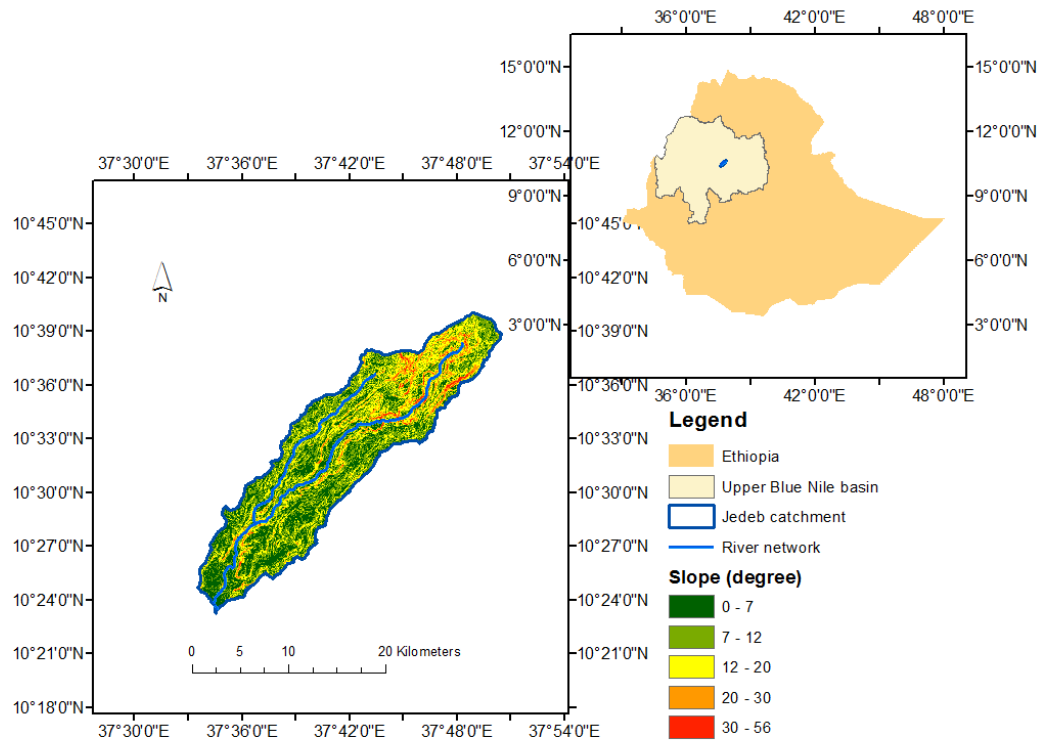
Figure 1. Location and topographic map of the Jedeb catchment in the Abbay (Upper Blue Nile) basin,